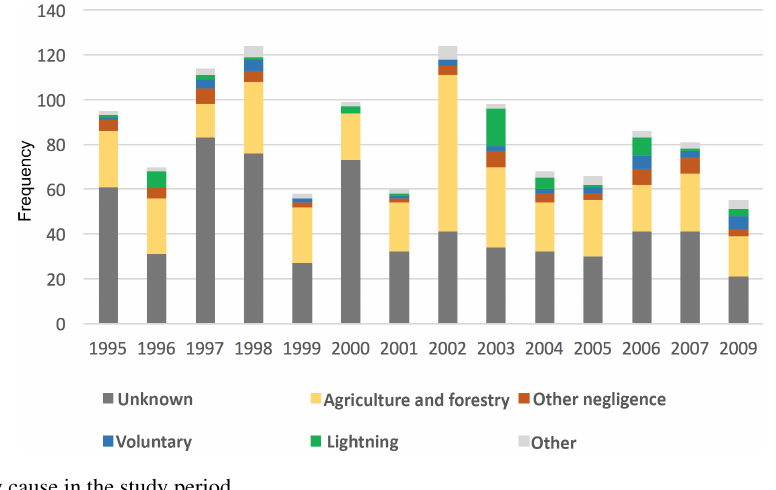
Figure 5. Fire ignitions by cause in the study period.